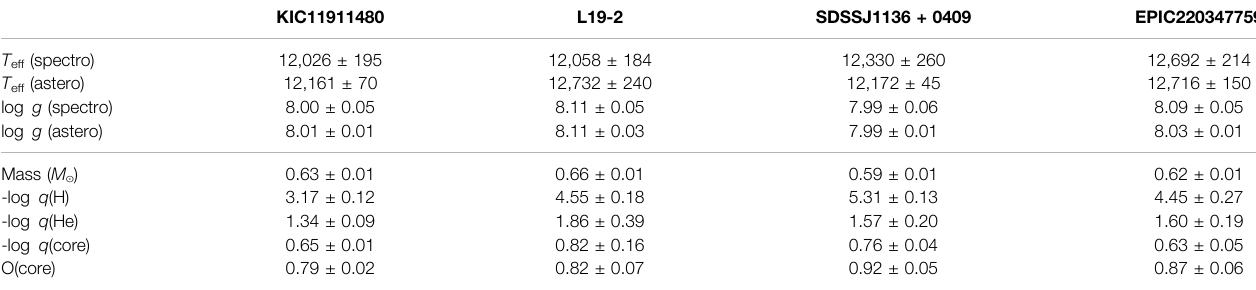
TABLE 1 | Key parameters derived from asteroseismology for the 4 ZZ Ceti pulsators